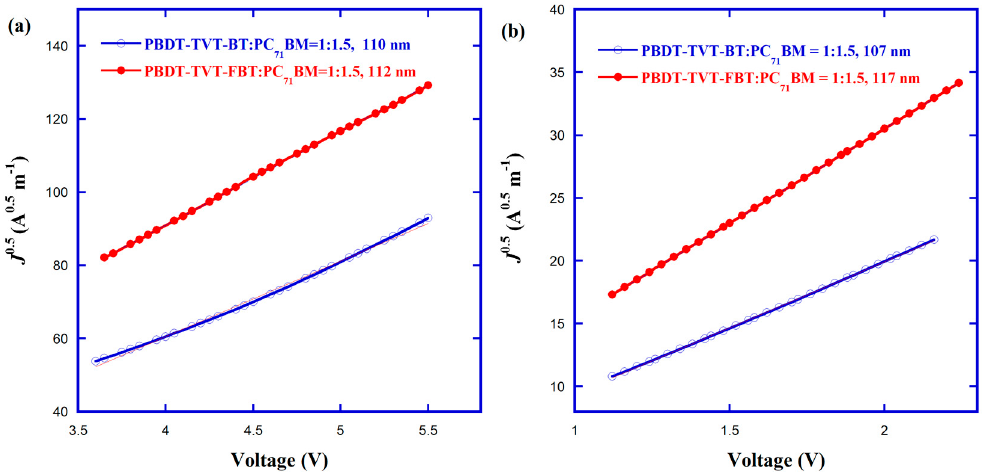
Figure 9. Fitting J 1 / 2 –V characteristics of hole-only ( a ) and electron-only ( b ) devices for PBDT-TV-BT:PC 71 BM and PBDT-TVT-FBT:PC 71 BM. Table 4. Mobilities and μ h/ μ e ratio of the studied polymers PBDT-TVT-BT and PBDT-TVT-FBT. Active layer